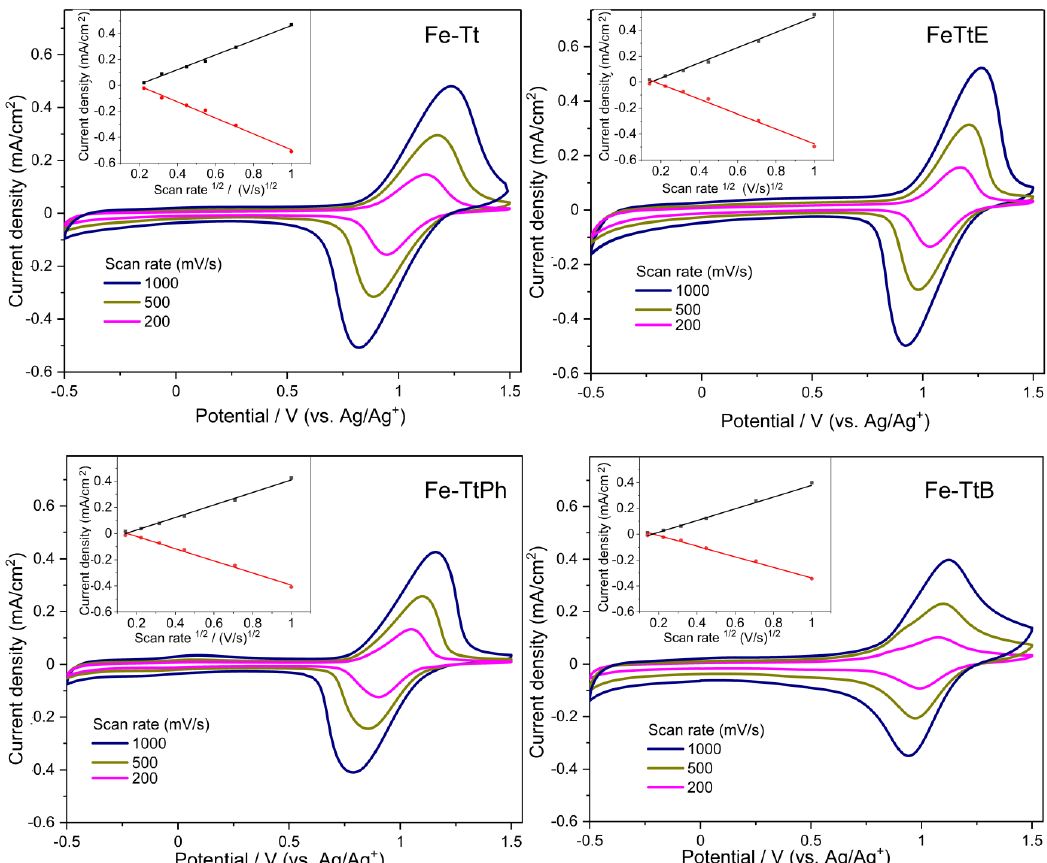
Figure 3. Cyclic voltammetry records of Fe-MSP films taken with different scanning rates. Insets show the dependences of the anodic and cathodic peak currents on the square root of scanning rate.